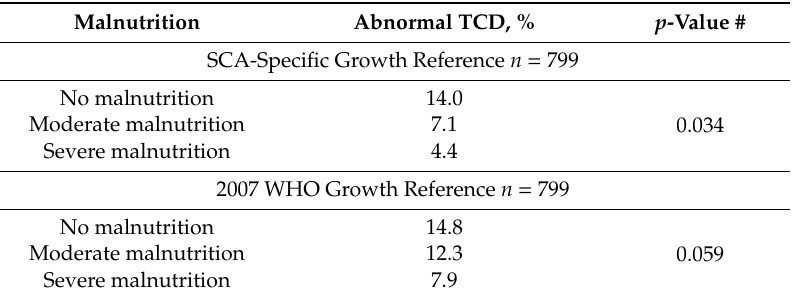
Table 2. Proportion of children with sickle cell anemia (SCA) aged 5–12 years old in Nigeria (SPRING cohort; n = 799) with abnormal transcranial Doppler (TCD) values ( > 200 cm / s): World Health Organization (WHO) compared to the SCA-Specific growth reference.